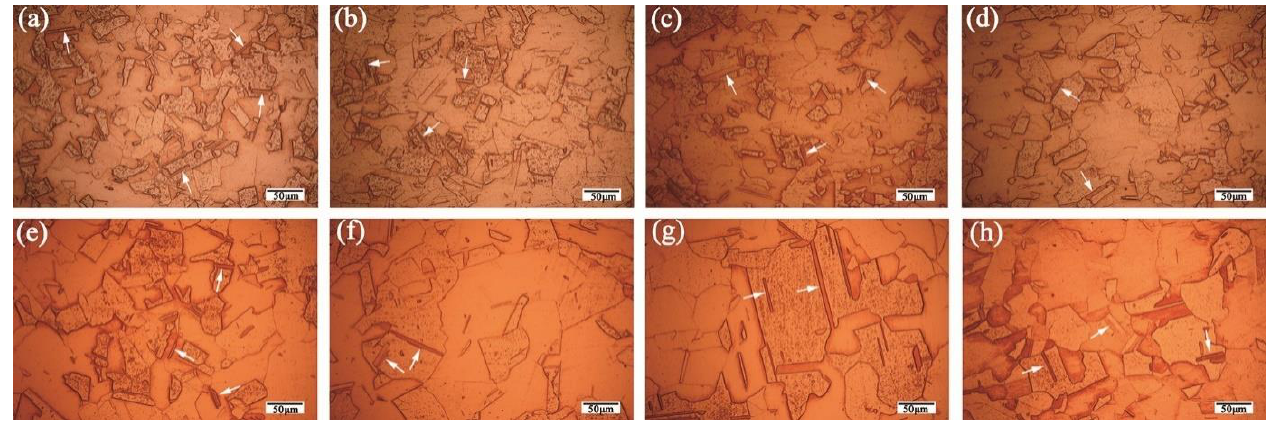
Figure 10. ( a – d ) Microstructures of four zones for U-Shaped strips. ( e – h ) Microstructures of four zones for flat copper strips: ( a ) Edge zone of U-Shaped strips; ( b ) Straight flange zone; ( c ) Bending zone; ( d ) Top zone; ( e ) Edge zone of flat strips; ( f ) Second zone; ( g ) Third zone; ( h ) Middle zone.